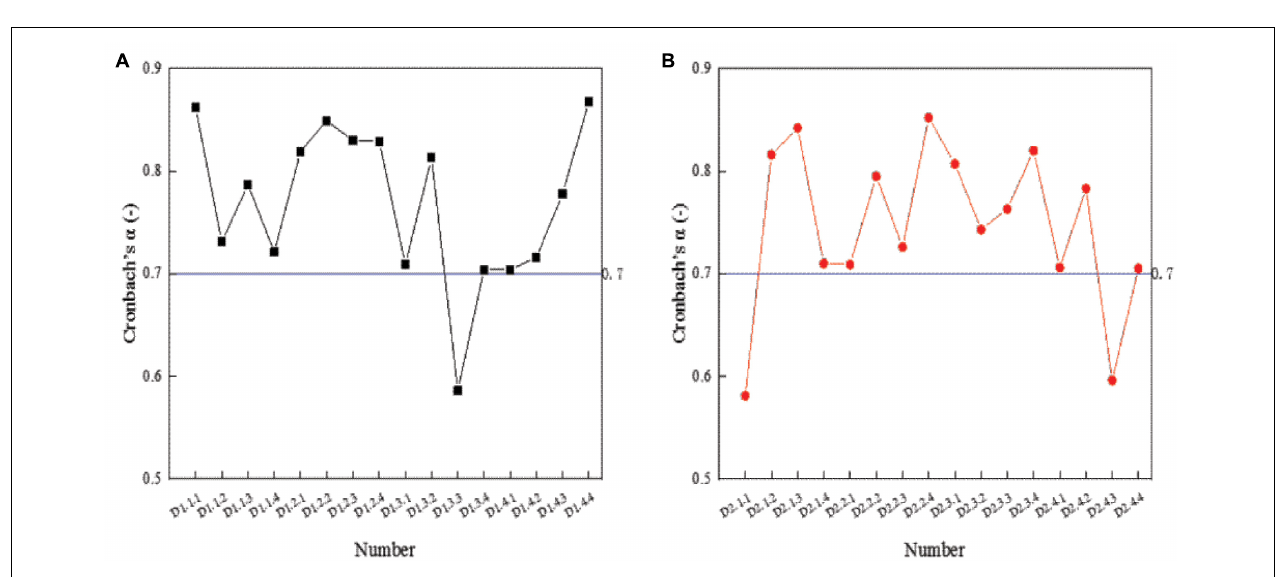
FIGURE 2 | Reliability test results of the scale. (A) Reliability analysis results of entrepreneurship. (B) Reliability analysis results of cultural diversity cultivation.